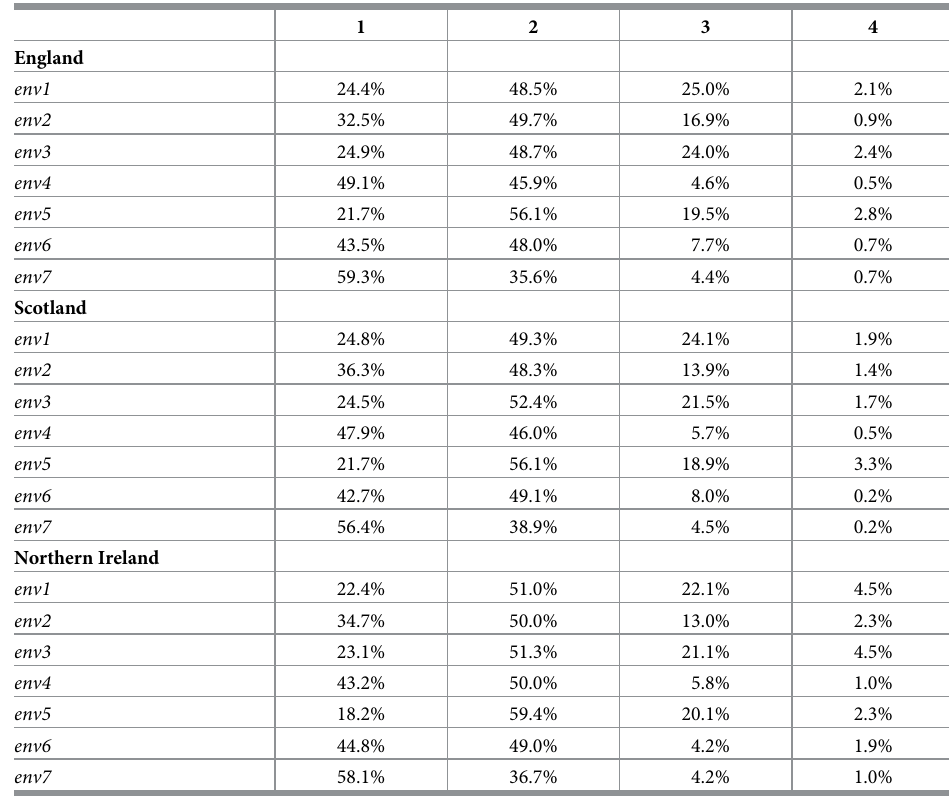
Table 4. Responses to the attitudinal